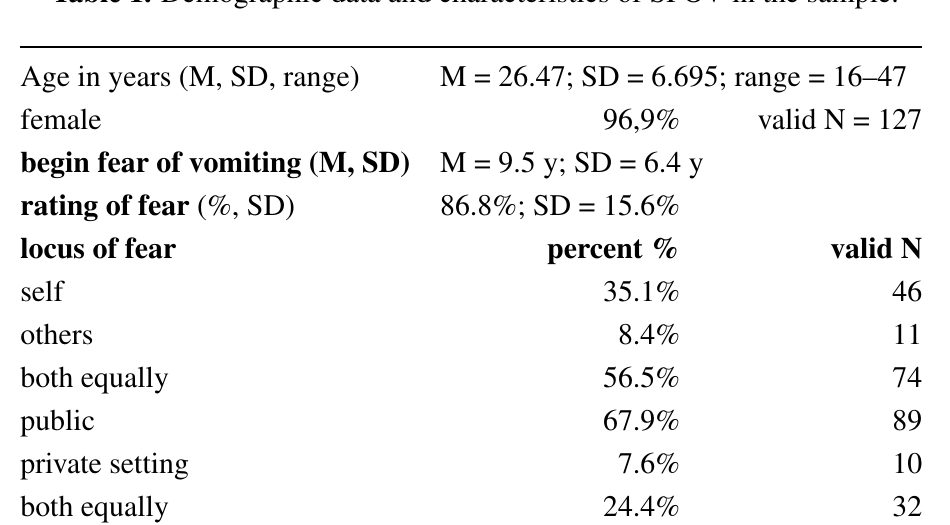
Table 1. Demographic data and characteristics of SPOV in the